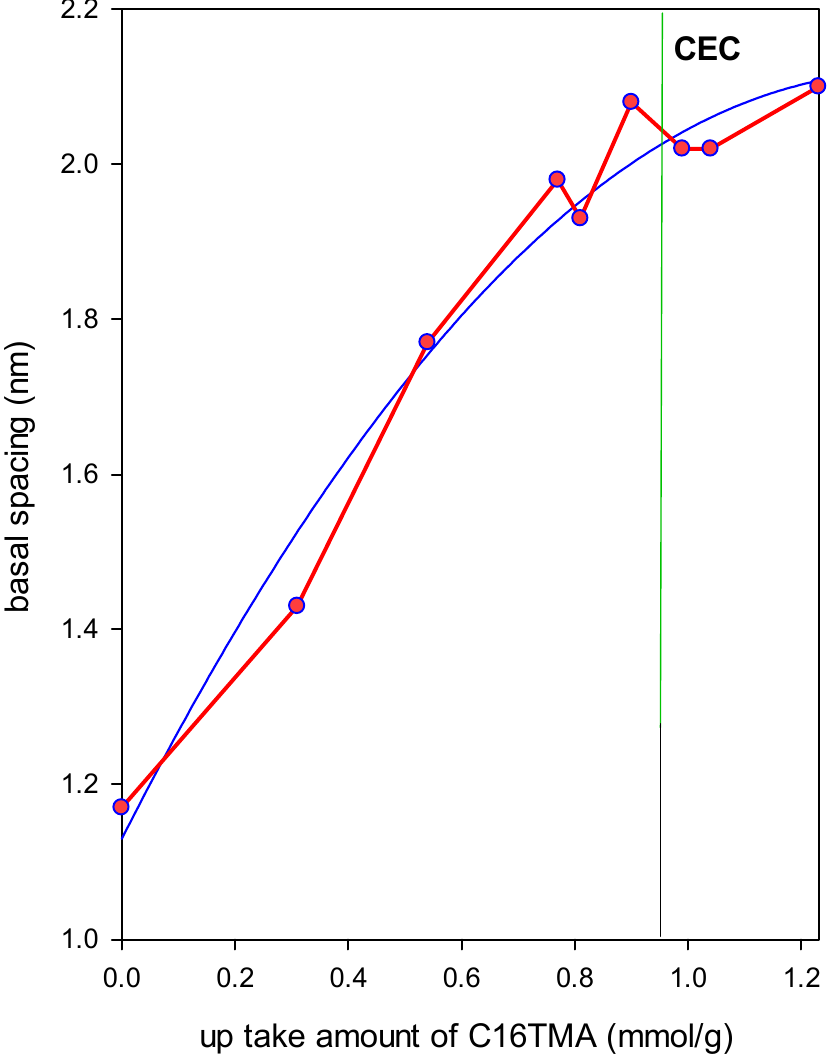
Figure 4. Variation of the basal spacing expansion with the up take amount of the surfactants (mmole/g, red line), blue line corresponds to the fitting curve. red line), blue line corresponds to the fitting